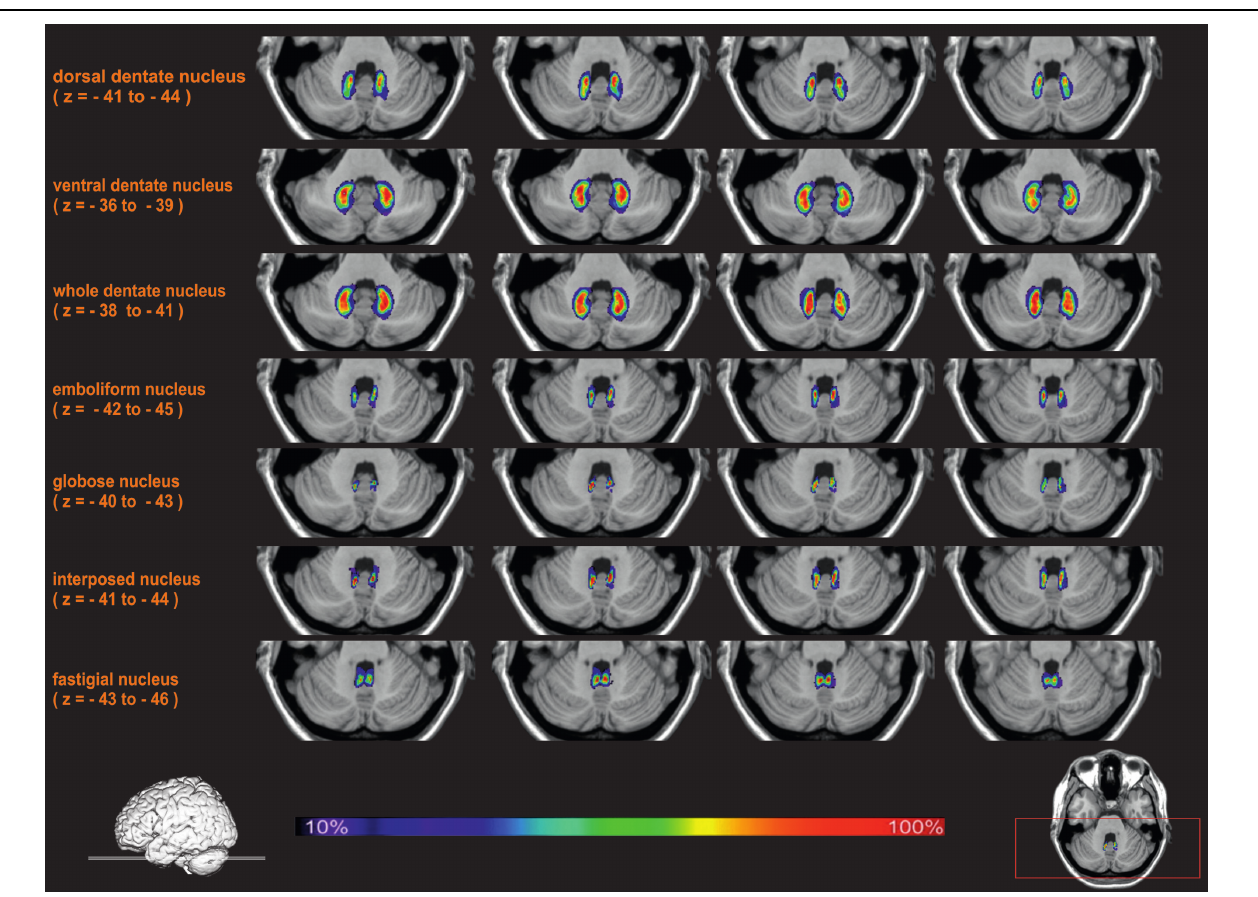
FIGURE 5 | Exemplary transversal sections through the stereotaxic MNI-Colin27 reference brain with probability maps of the cerebellar nuclei. The maximal overlap in each nucleus was 100% (shown in red). Regions with lower probabilities correspond to a higher intersubject variability and are shown in blue and green colors.